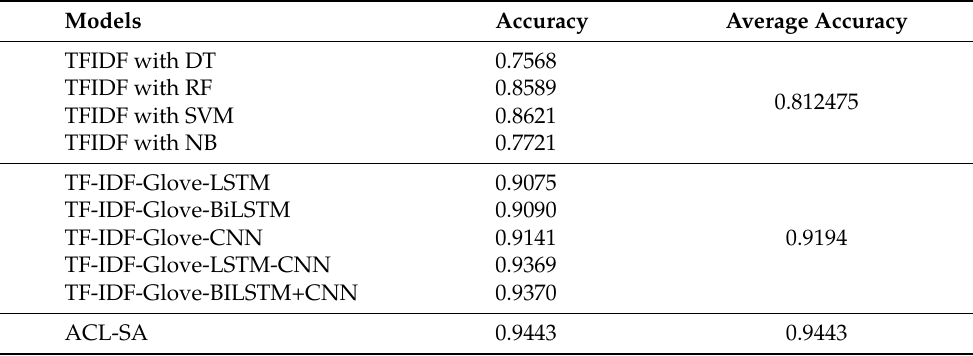
Table 5. Sentiment140-MV accuracy compression with baseline models and our proposed models.